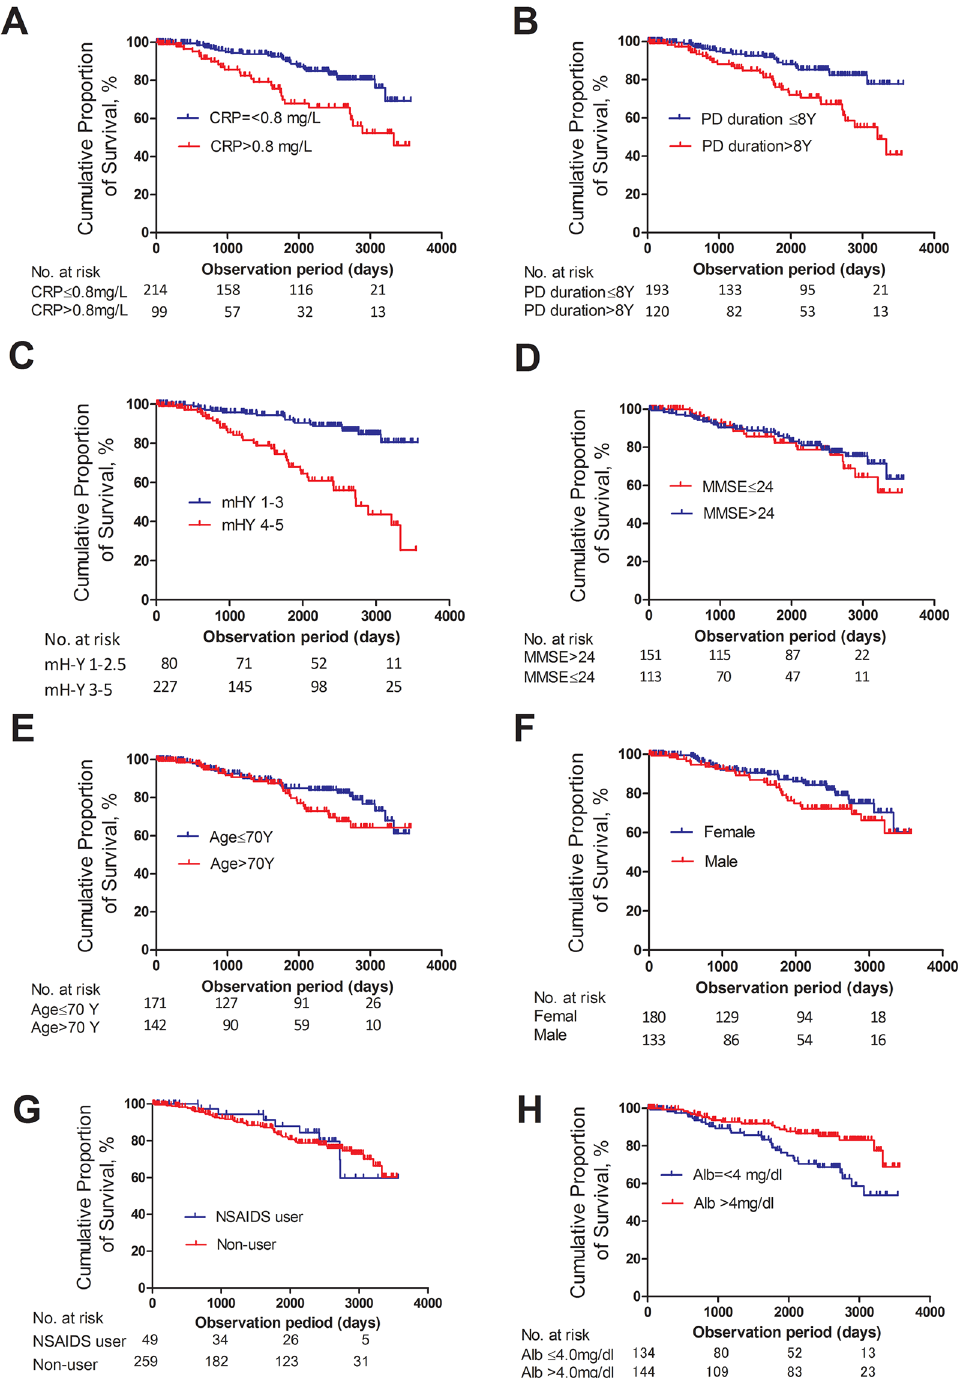
Fig 2. Survival curves of PD patients according to baseline clinical features. Cumulative survival rates according to CRP levels (A), PD disease duration (B), modified H-Y stages (C), MMSE score (D), age (E), sex (F), NSAID use (G), and serum albumin (H). There was a statistically significant difference in the survival rate between patients with CRP > 0.8 mg/L and (cid:1) 0.8 mg/L ( p = 0.00004) (A), patients with PD disease duration (cid:1) 8 years and > 8 years ( p = 0.00004) (B), those with modified H-Y 1 – 3 and modified H-Y 4 – 5 ( p = 0.00001) (C), and those with albumin > 4.0mg/dL and albumin (cid:1) 4.0mg/dL ( p = 0.004). However, the survival rate was not influenced by MMSE score, ( p = 0.499) (D), age ( p = 0.117) (E), sex ( p = 0.186) (F), or NSAID use ( p = 0.846). Statistical significance was tested using the Log-rank test.